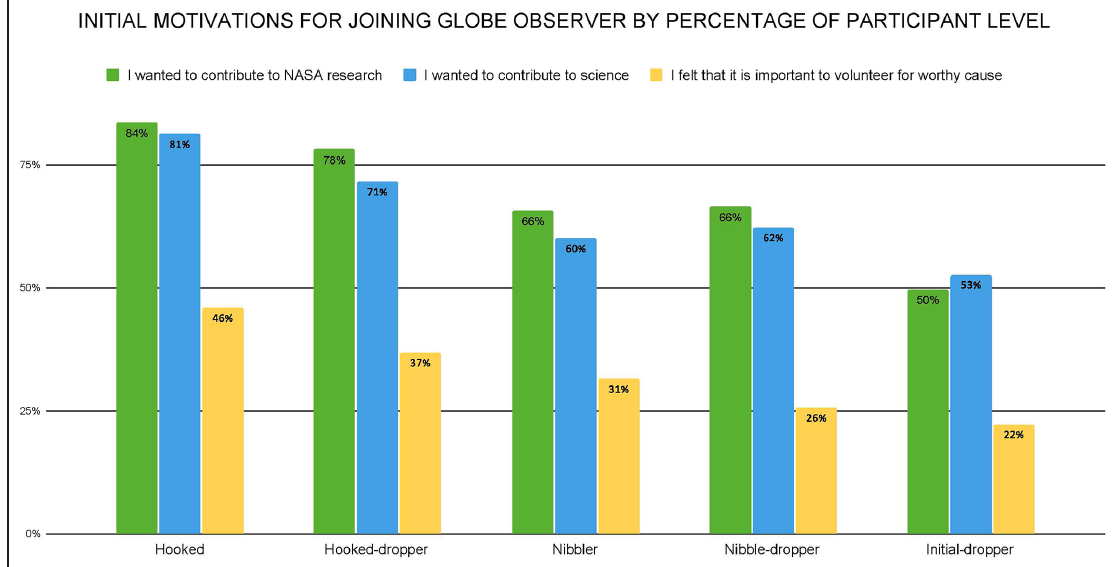
Figure 5 The distribution of the top three initial motivations of all participants who joined GLOBE Observer, by framework category. (These were also the top three reasons for all participant categories except for nibble- droppers, for whom the top three were contributing to NASA science, contributing to science, and learning about clouds, and the fourth was volunteering for a worthy